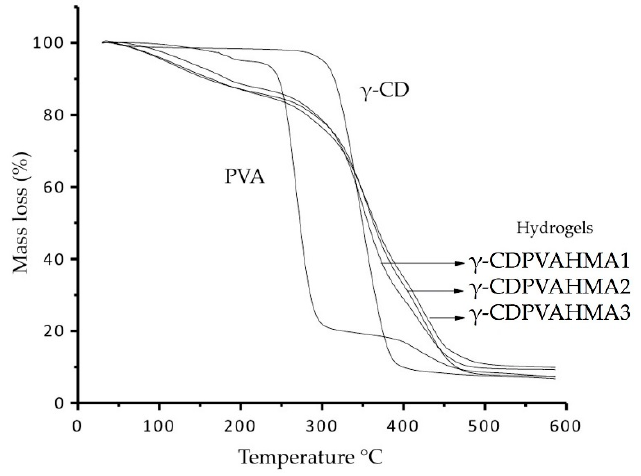
Figure 10. Thermograms of PVA, γ -CD, γ -CDPVAHMA1, γ -CDPVAHMA2, and γ -CDPVAHMA3.